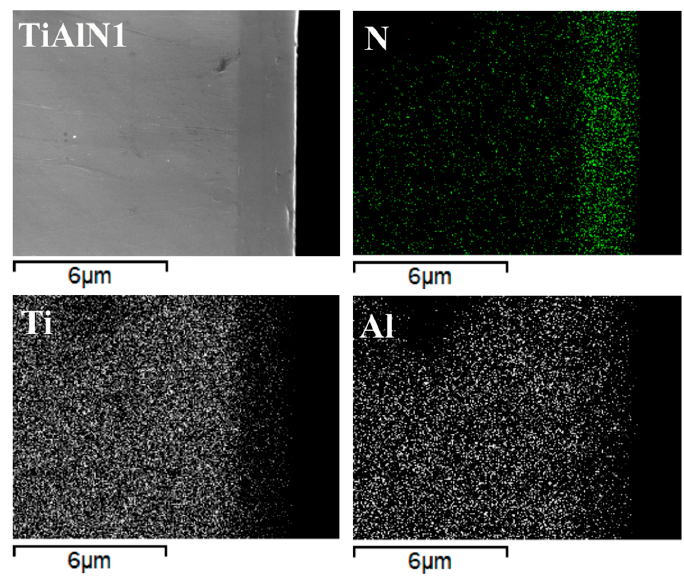
Figure 2. Cross section of TiAlN1 sample: coating morphology and nitrogen, titanium and aluminum concentration maps.